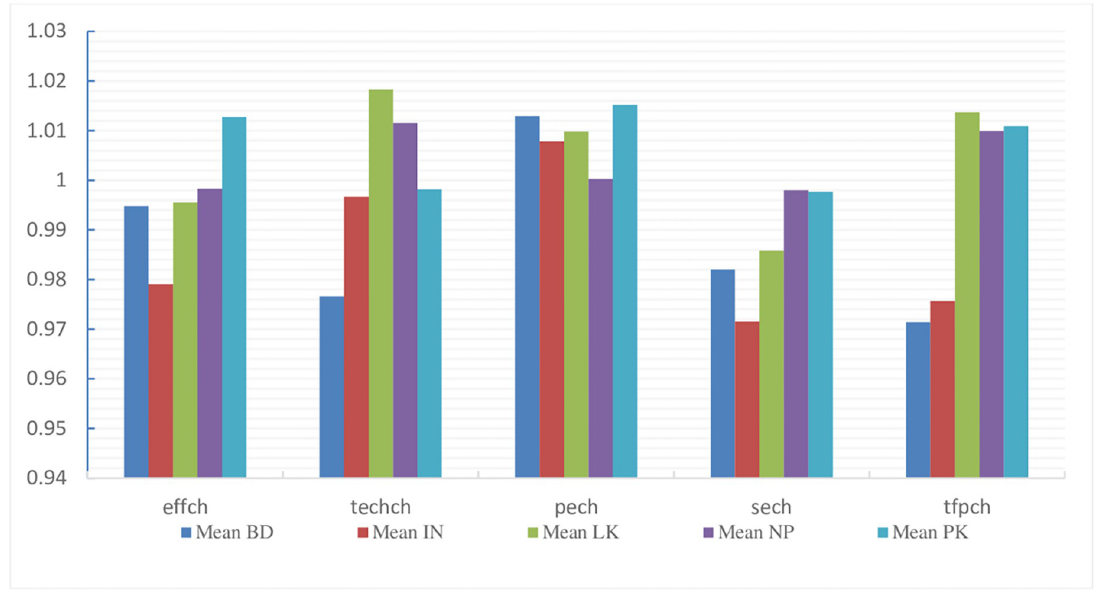
Fig 5. Mean productivity change in all 5